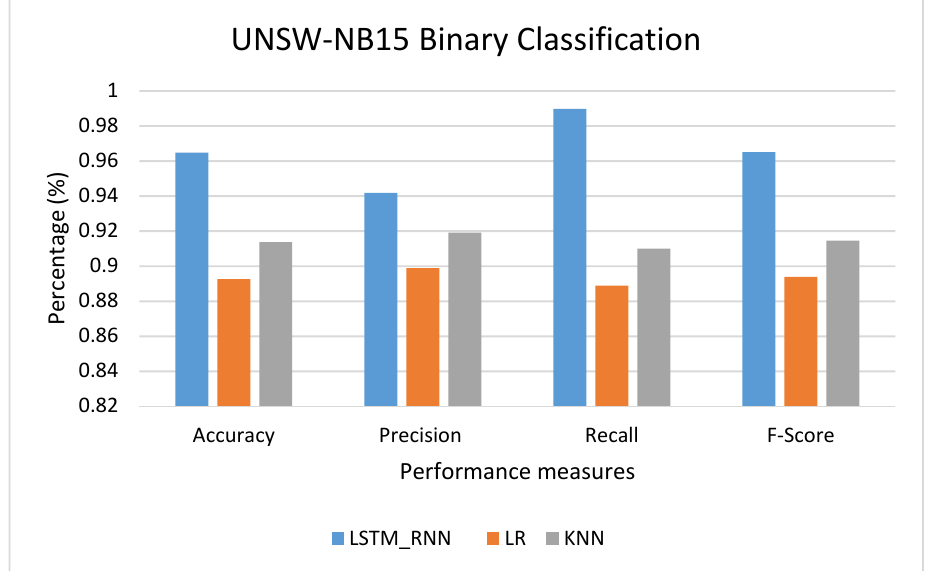
Figure 12. UNSW-NB15 Binary classification performance comparison. can be seen, the LSTM_RNN and KNN had relative performance in terms of Accuracy and Precision. However, the Recall of LSTM_RNN, LR was much better than that of KNN, where the true positive value was much better than KNN. On the other side, LR still has lower precision, accuracy, Recall, and F-score than LSTM_RNN.